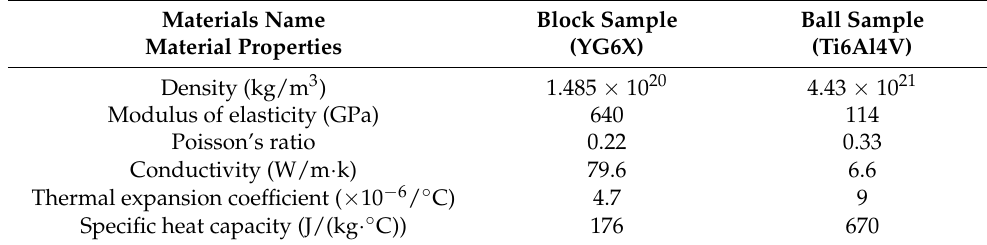
Table 2. Material properties of the block and ball samples.